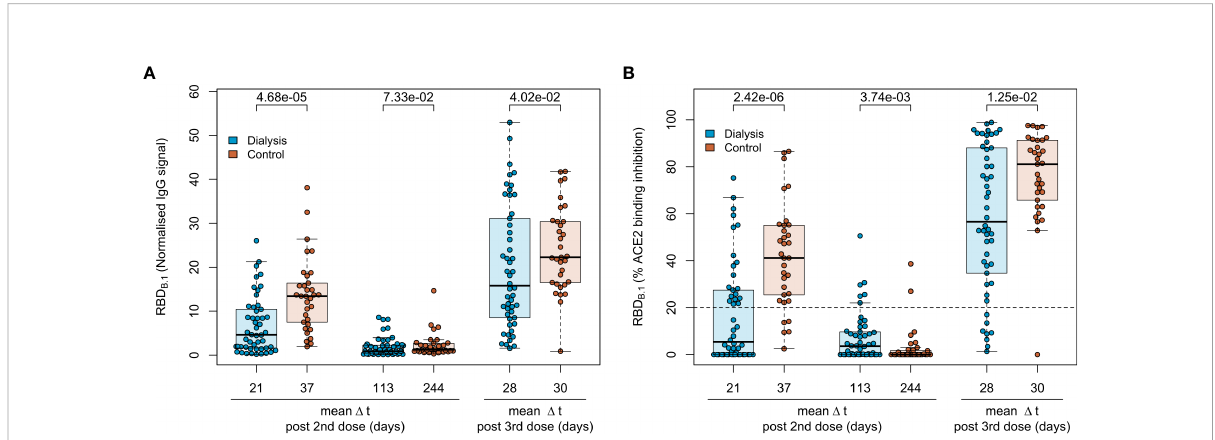
FIGURE 2 Humoral immune response in haemodialysis patients after a triple vaccination with BNT162b2. IgG response (A) and ACE2 binding inhibition (B) towards the SARS-CoV-2 B.1 RBD isolate were measured in plasma from haemodialysis patients (blue circles, n = 50) and controls (orange circles, n=33) using MULTICOV-AB (A) or an ACE2-RBD competition assay (B) after double or triple vaccination with BNT162b2 at the indicated time points. Data is displayed as normalised median fl uorescence intensity (MFI) signal (A) for IgG binding or as % ACE2 binding inhibition where 100% indicates maximum inhibition and 0% no inhibition (B) . Samples with an ACE2 binding inhibition of less than 20% (dashed line) are classi fi ed as non-responders. Boxes represent the median, 25th and 75th percentiles, whiskers show the largest and smallest non-outlier values. Outliers were determined by 1.5 times IQR. Mean sampling time in days after two-dose BNT162b2 vaccination as D t is displayed on the x-axis. Statistical signi fi cance was calculated by two-sided Mann-Whitney-U test. P-values for relevant comparisons are given above the sample groups. Signi fi cance was de fi ned as p < 0.05. Response data from dialysed individuals from day 21 and day 113 after the second BNT162b2 dose were already published before as part of Strengert et al. (16) and Dulovic et al.